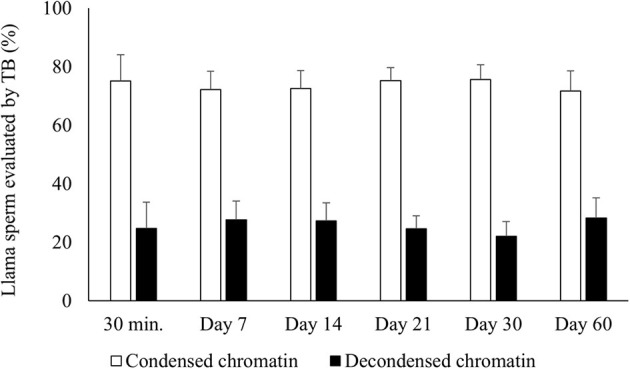
Percentages of air-dried llama sperm with condensed (TB negative) and decondensed chromatin (TB intermediate + positive). Air-drying was evaluated after different times of preservation (30 min and 7, 14, 21, 30, and 60 days) (n = 4, r = 4). TB, Toluidine blue stain for evaluating sperm chromatin condensation. No significant differences were observed between the periods of preservation within each category (p > 0.05).